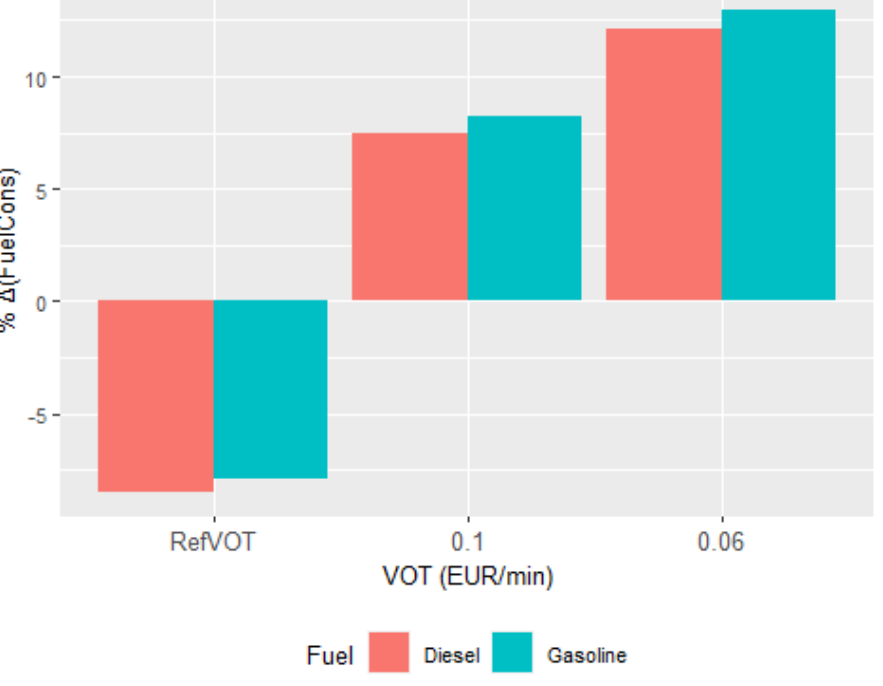
Figure 6. Percentage changes in total fuel consumption compared to the reference